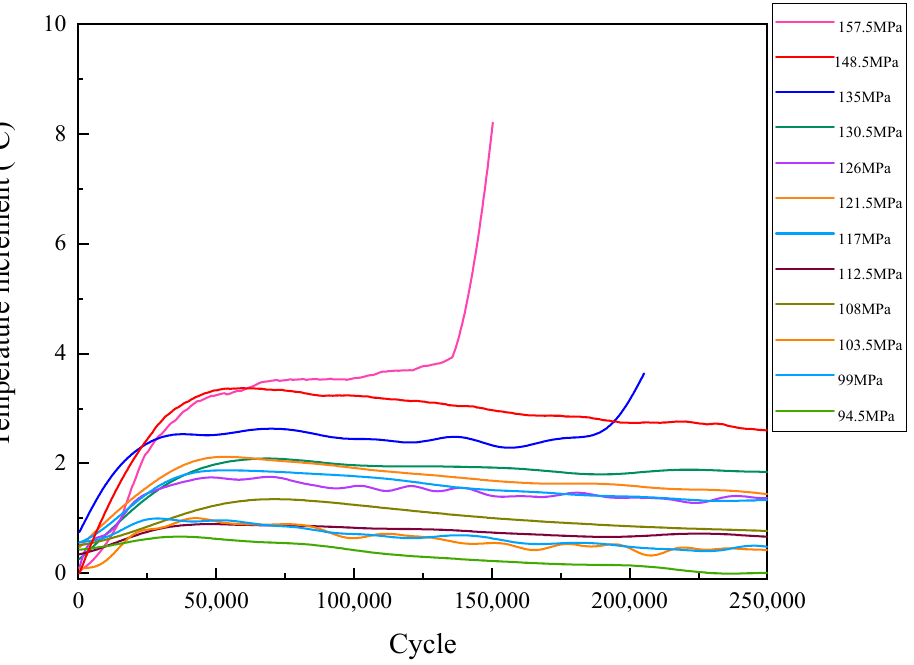
Figure 6. Temperature evolution during fatigue at different loading levels.